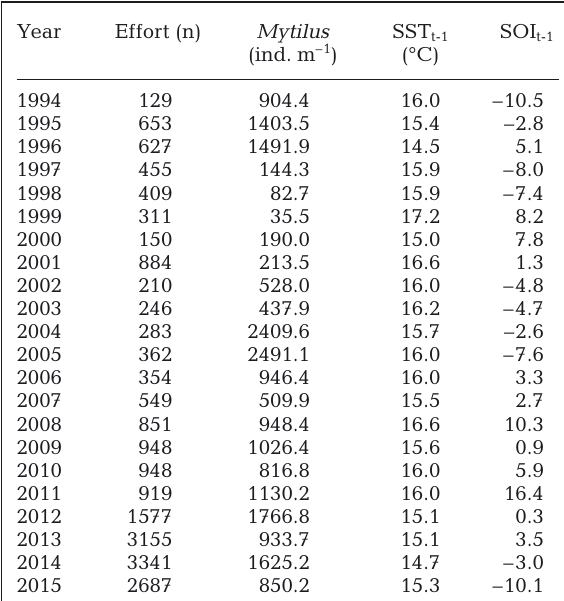
Table A1. Summary table of the data (1994 to 2015 yearly averages) used for modelling. Mytilus : Mytilus galloprovin- cialis abundance, SST: sea surface temperature, SOI = southern oscillation